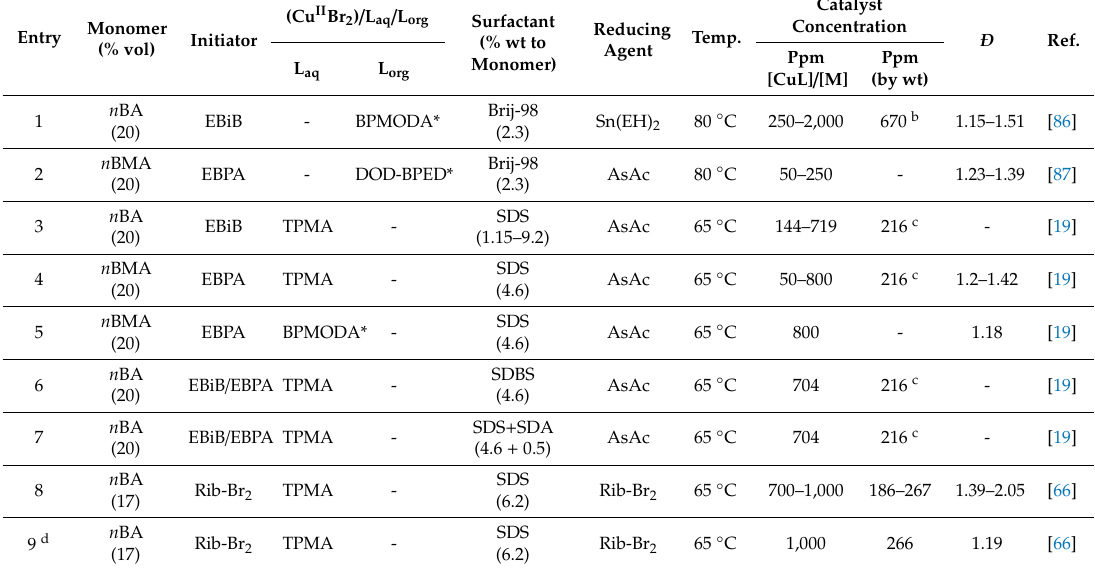
Table 2. ARGET ATRP in miniemulsion with di ff erent surfactants and catalysts a